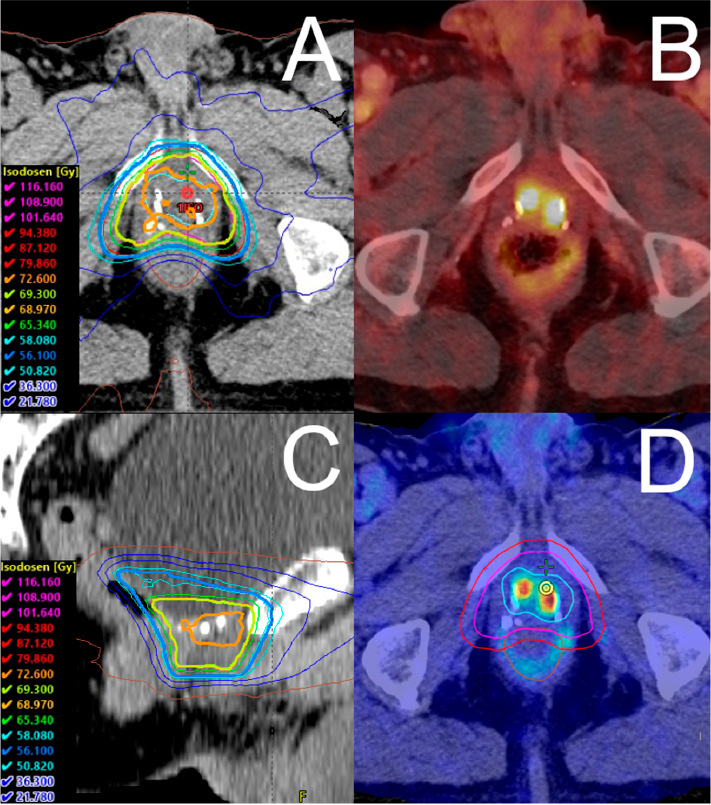
Figure 1. Exemplary dose distribution of salvage radiotherapy. Shown is an exemplary dose distribu- tion in a patient receiving 18 F-PSMA-1007 PET/CT-guided salvage radiotherapy in ( A ) axial view and ( C ) sagittal view. The corresponding 18 F-PSMA-1007 PET/CT shows a PET-positive recurrence in the prostatic bed ( B ). The patient received volumetric modulated arc therapy with a simultaneous integrated boost to the local recurrence in three dose levels. ( D ) shows the fused PET/CT and corresponding radiotherapy contours. In 33 fractions, we prescribed single doses of 1.7 Gy for the PTV (red line), 2.1 Gy for the PTV Boost1 (pink line), and 2.2 Gy for the PTV Boost2 (turquoise line), resulting in total doses of 56.1 Gy (blue isodose), 69.3 Gy (bright green isodose), and 72.6 Gy (orange isodose),